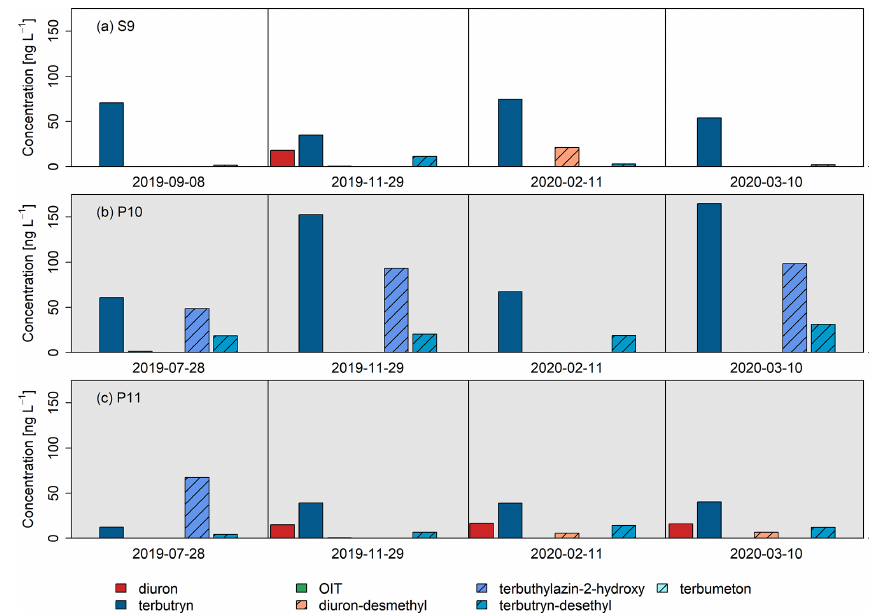
Figure 9. Samples in drainage pipes during four events. (a) Pipe S9 collects street runoff. (b) Pipes P10 and (c) P11 collect infiltrated water around the houses (percolation water).